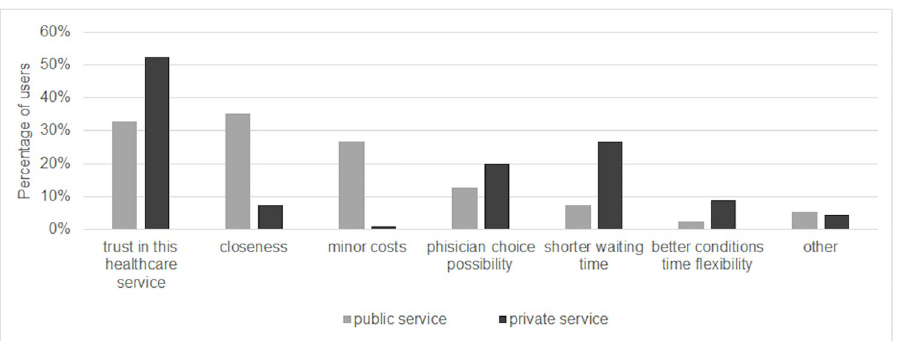
Fig 2. Reasons endorsed for the choice of public or private